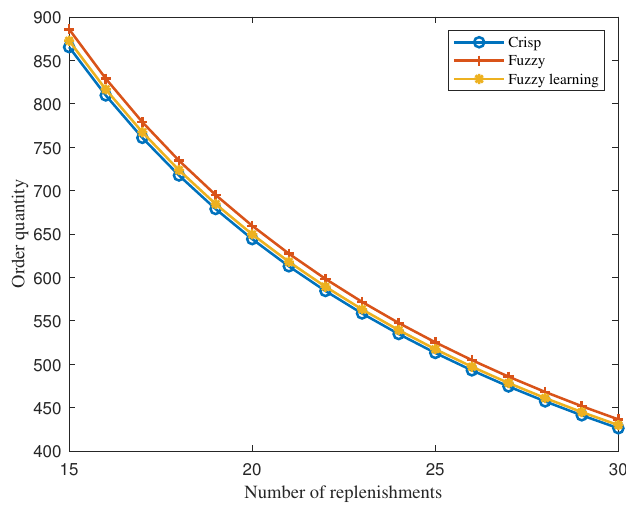
Figure 3. Order quantity versus the number of replenishments for the three models.